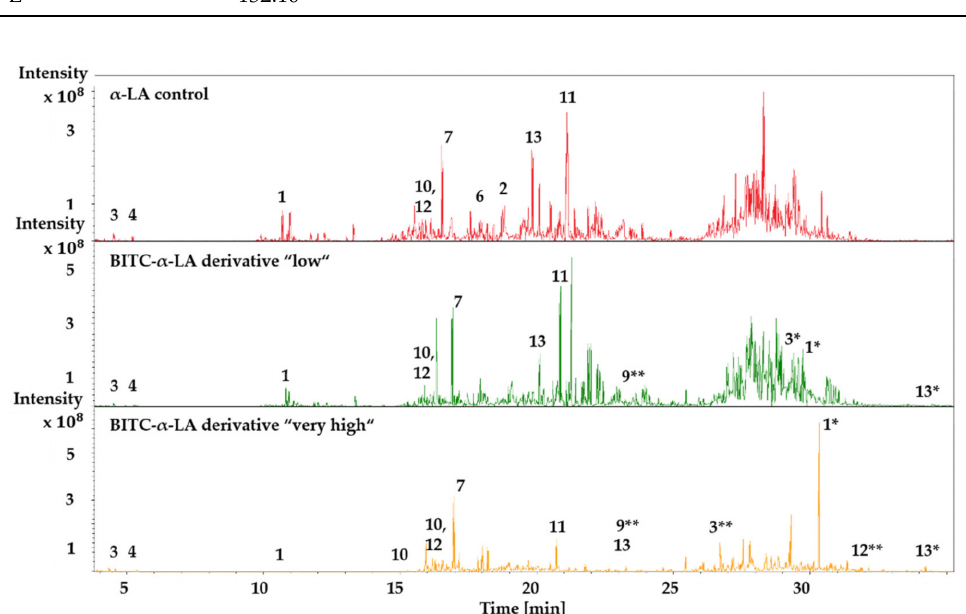
Figure 7. Total ion chromatograms (TIC) of the tryptically hydrolyzed untreated α -LA (red) and the tryptically hydrolyzed BITC- α -LA derivatives “low” (green) and “very high” (orange). The main peptide signals were labeled numerically. Identical peptide sequences are marked with the same number, corresponding peptides that have been modified are marked with an “*”, while elongated peptides resulting from BITC modification were highlighted with “**”. The numbering of the peptides is given in Table